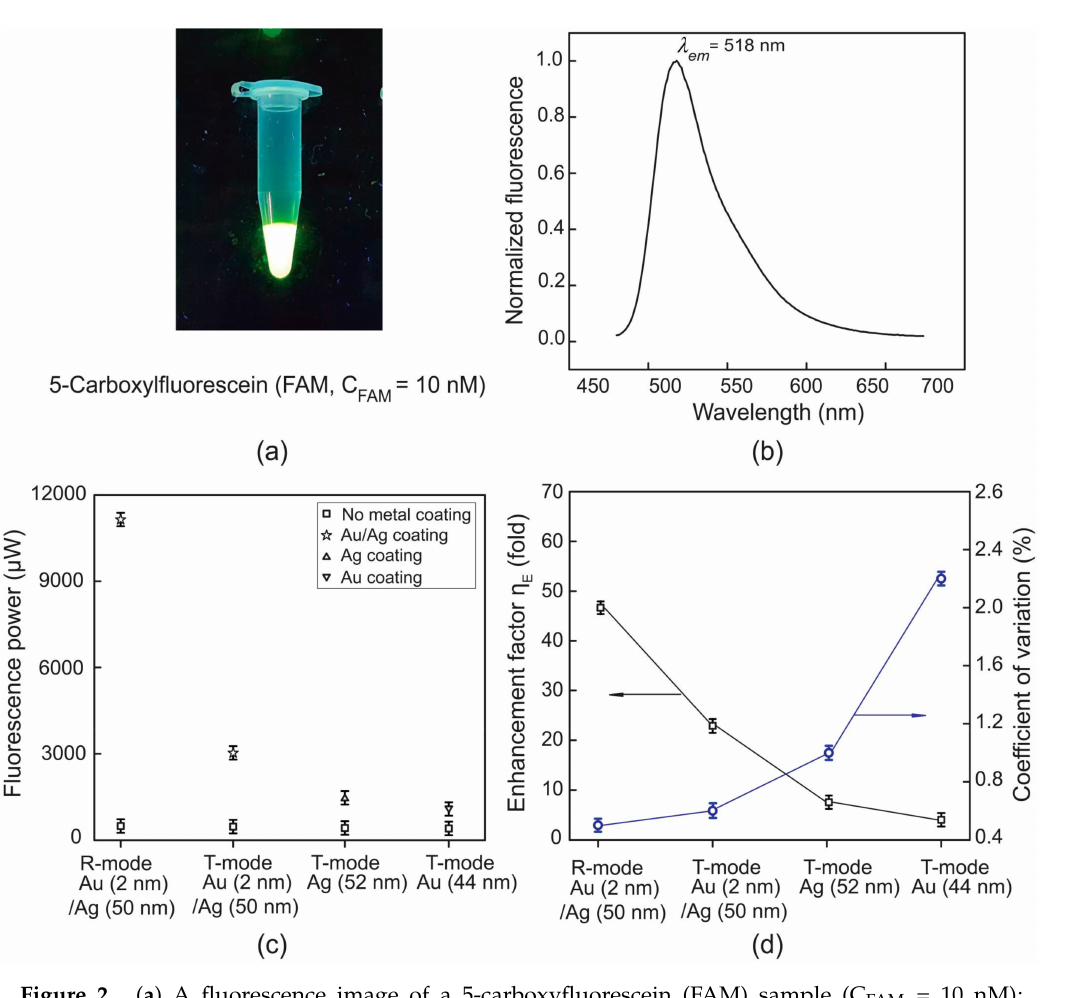
Figure 2. ( a ) A fluorescence image of a 5-carboxyfluorescein (FAM) sample (C FAM = 10 nM); ( b ) an emission spectrum of FAM; ( c ) fluorescence power for various combination of plasmonic chips and setups; ( d ) estimated enhancement factor and the corresponding coefficient of variation